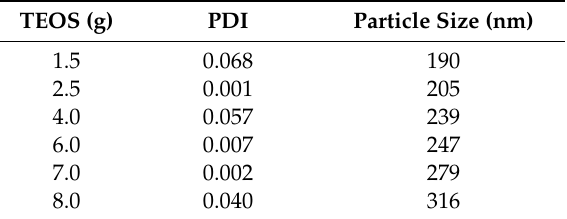
Figure 3. Dynamic light scattering (DLS) size distribution curves for colloidal silica particles prepared using different TEOS concentrations. Table 1. Polydispersity index (PDI) and particle size distribution results obtained from